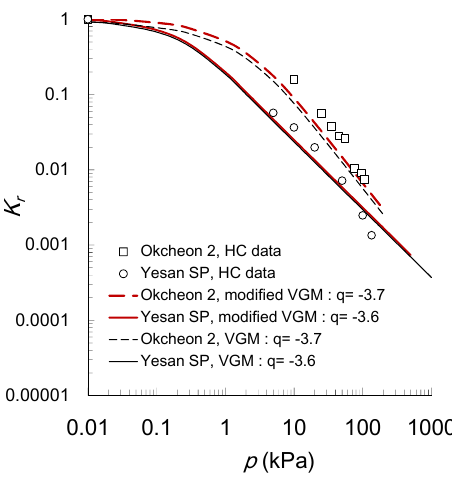
Figure 10. Comparison of the measured hydraulic conductivities with the modified model in Group